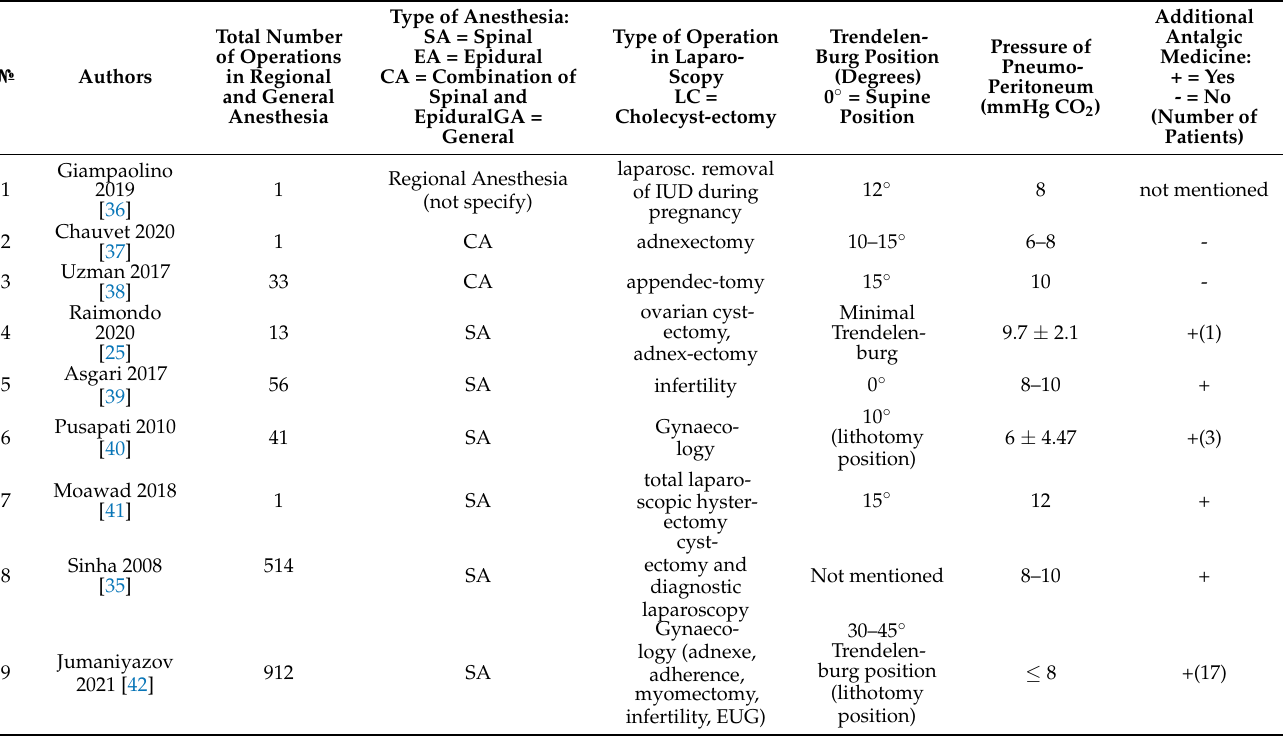
Table 2. Review of existing studies on regional anesthesia in gynecological laparoscopic